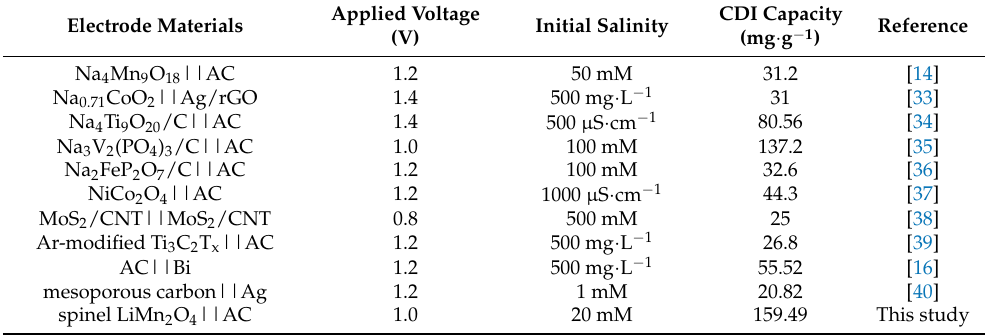
Table 1. The comparison of CDI desalination capacities with different electrode